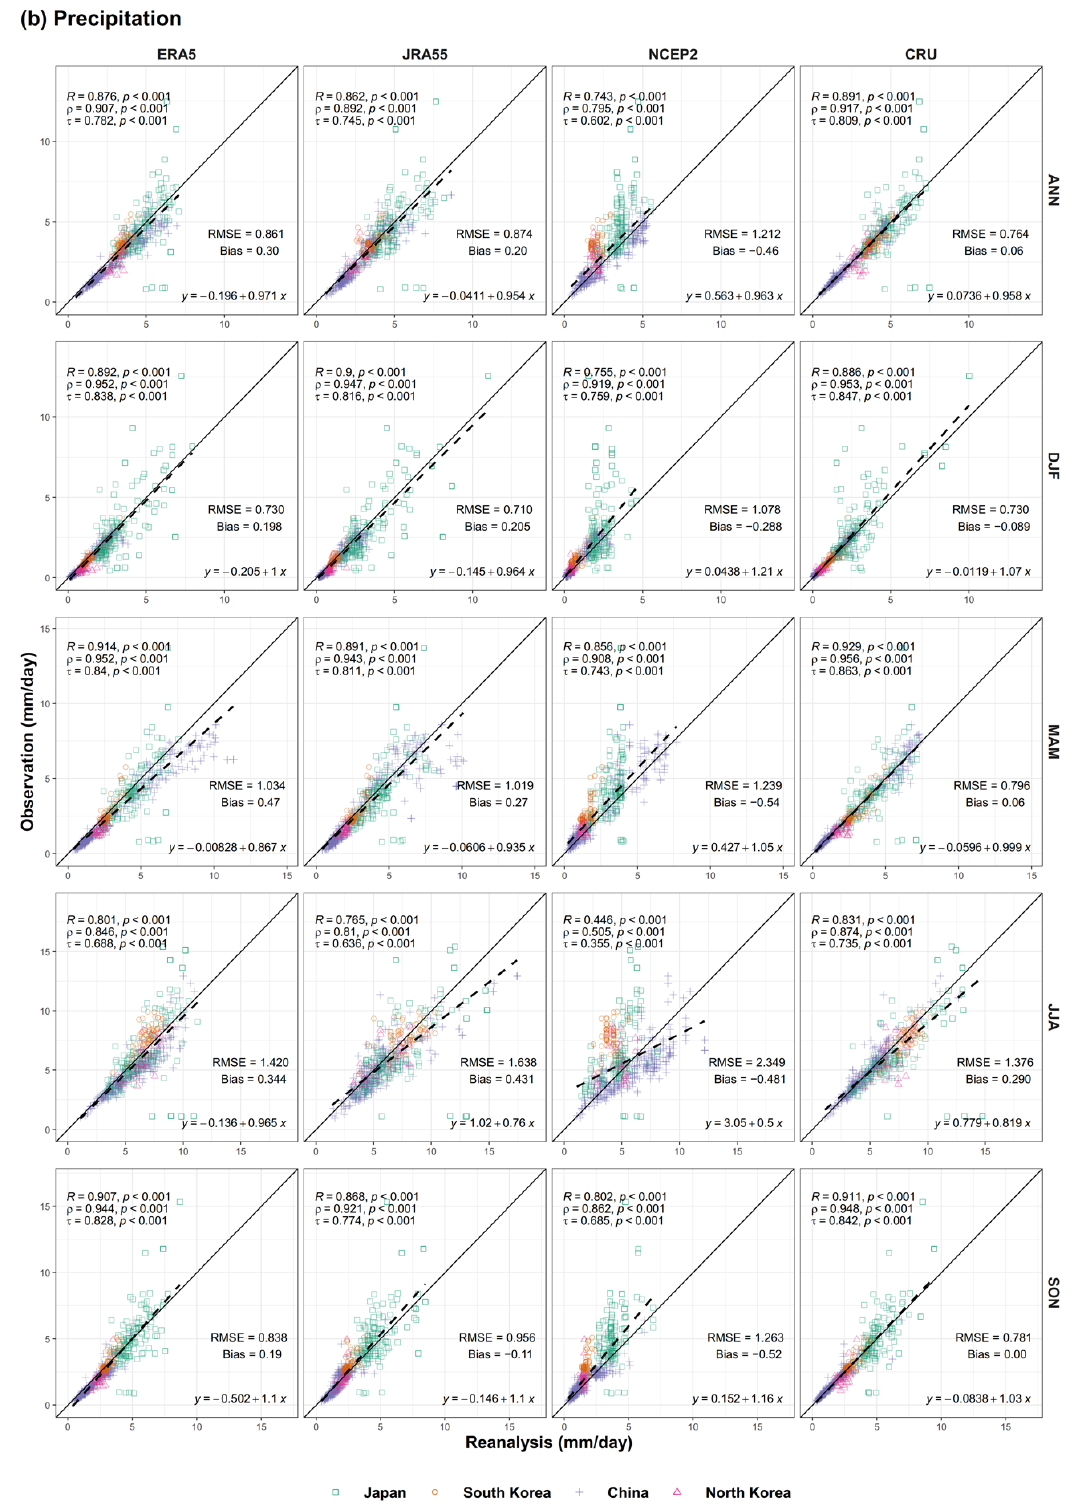
Figure 7. Scatter plots based on the values of ( a ) temperature and ( b ) precipitation from ERA5, JRA55, NCEP2, and CRU with observations for each station in the EAM region for annual and seasonal means during the forty years of 1981–2020 for North Korea, South Korea, and Japan and the thirty years of 1981–2010 for China. Correlation coefficients of Pearson (R), Spearman ( ρ ), and Kendall ( τ ) in the upper left and RMSE, bias, and the regression equation in the lower-right corners are shown.